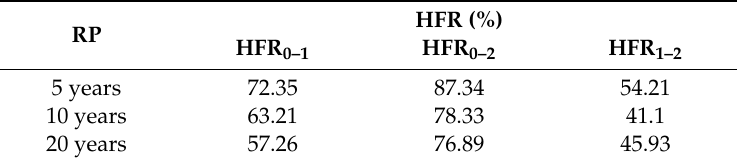
Table 5. Hour Flooded Reduction (HFR) index for design storm events.